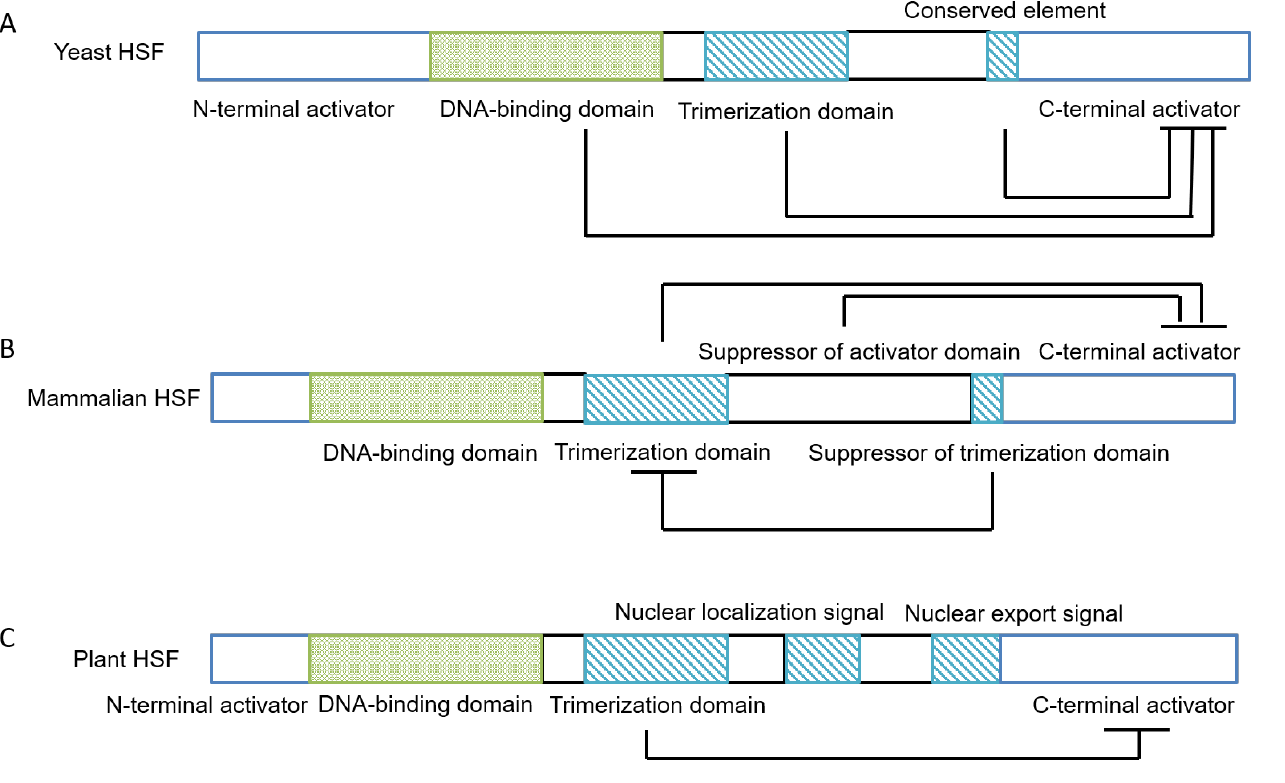
Figure 2. The structures of HSF genes. ( A ) Yeast. ( B ) Mammalian. ( C ) Plant. Abbreviations: HSF, heat shock factor.